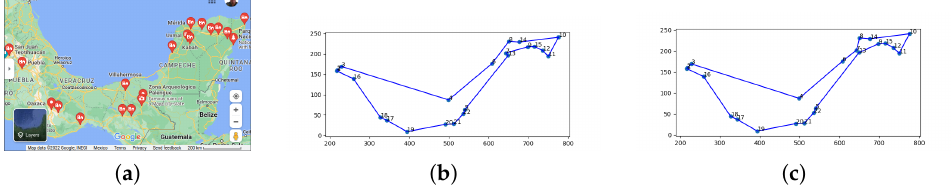
Figure 31. Map and solution of instance “ Mexico.tsp ”. ( a ) Map [58]; ( b ) Solution; ( c ) Improved